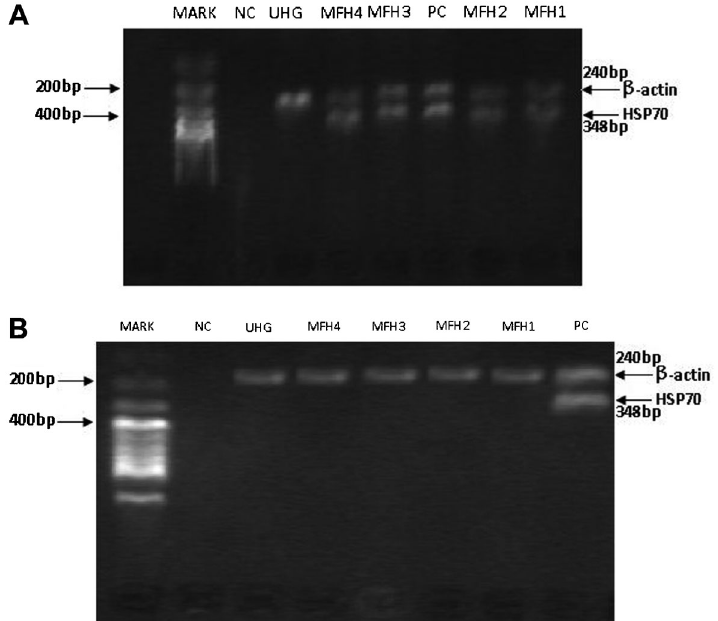
Figure 14. RT-PCR detection of Hsp70 expres- sion for SMMC-7721 cells after treatment for 12 h ( A ) and 24 h ( B ). NC: control group A (distilled water only); UHG: spiking group (8 g/L Fe 2 O 3 , no radiation); MFH4: MHF group with 8 g/L Fe 2 O 3 ; MFH3: MHF group with 6 g/L Fe 2 O 3 ; PC: control group B (MCF-7 cell group only); MFH2: MHF group with 4 g/L Fe 2 O 3 ; MFH1: MHF group with 2 g/L Fe 2 O 3